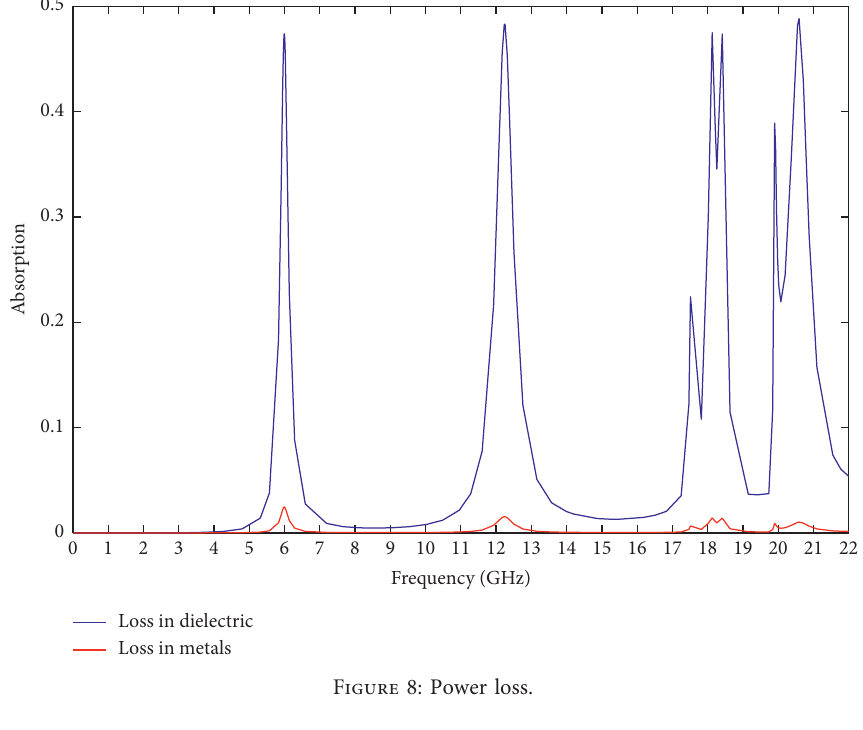
Figure 8: Power loss.